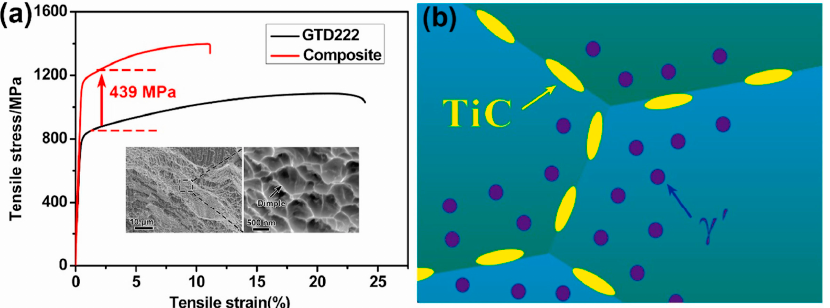
Figure 12. ( a ) Typical tensile stress-strain curves of LBPBF processed GTD222 alloy and TiC particle- reinforced Ni matrix composite; ( b ) schematic illustration of the strengthening mechanisms in TiC particle-reinforced Ni matrix composite [77].